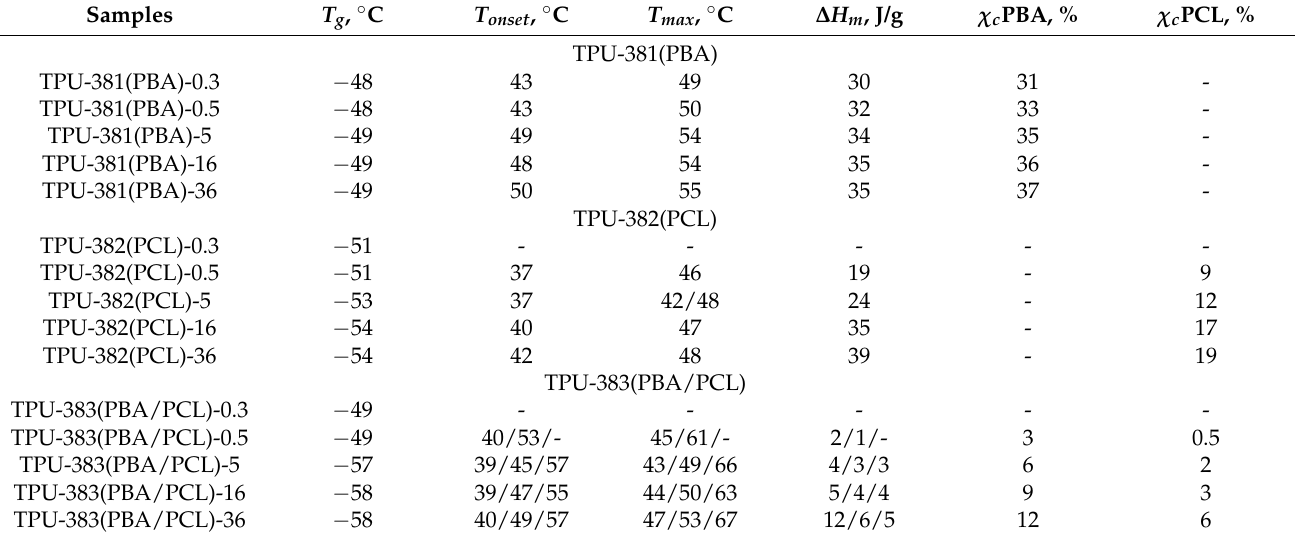
Table 2. Thermal parameters for the TPUs determined from the DSC